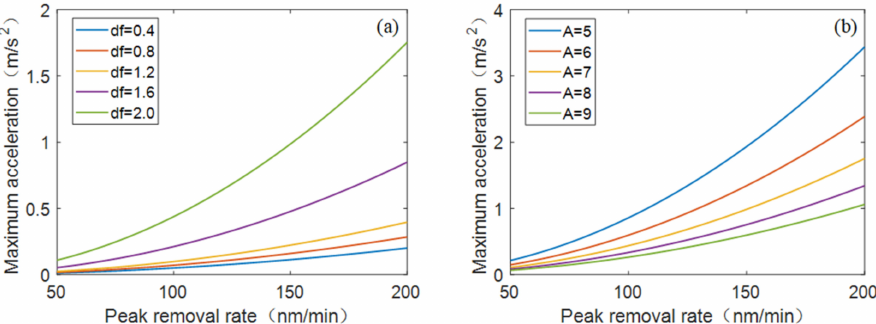
Figure 8. The dynamic performance requirement with the surface figure error frequency ( a ), and the surface figure error amplitude ( b